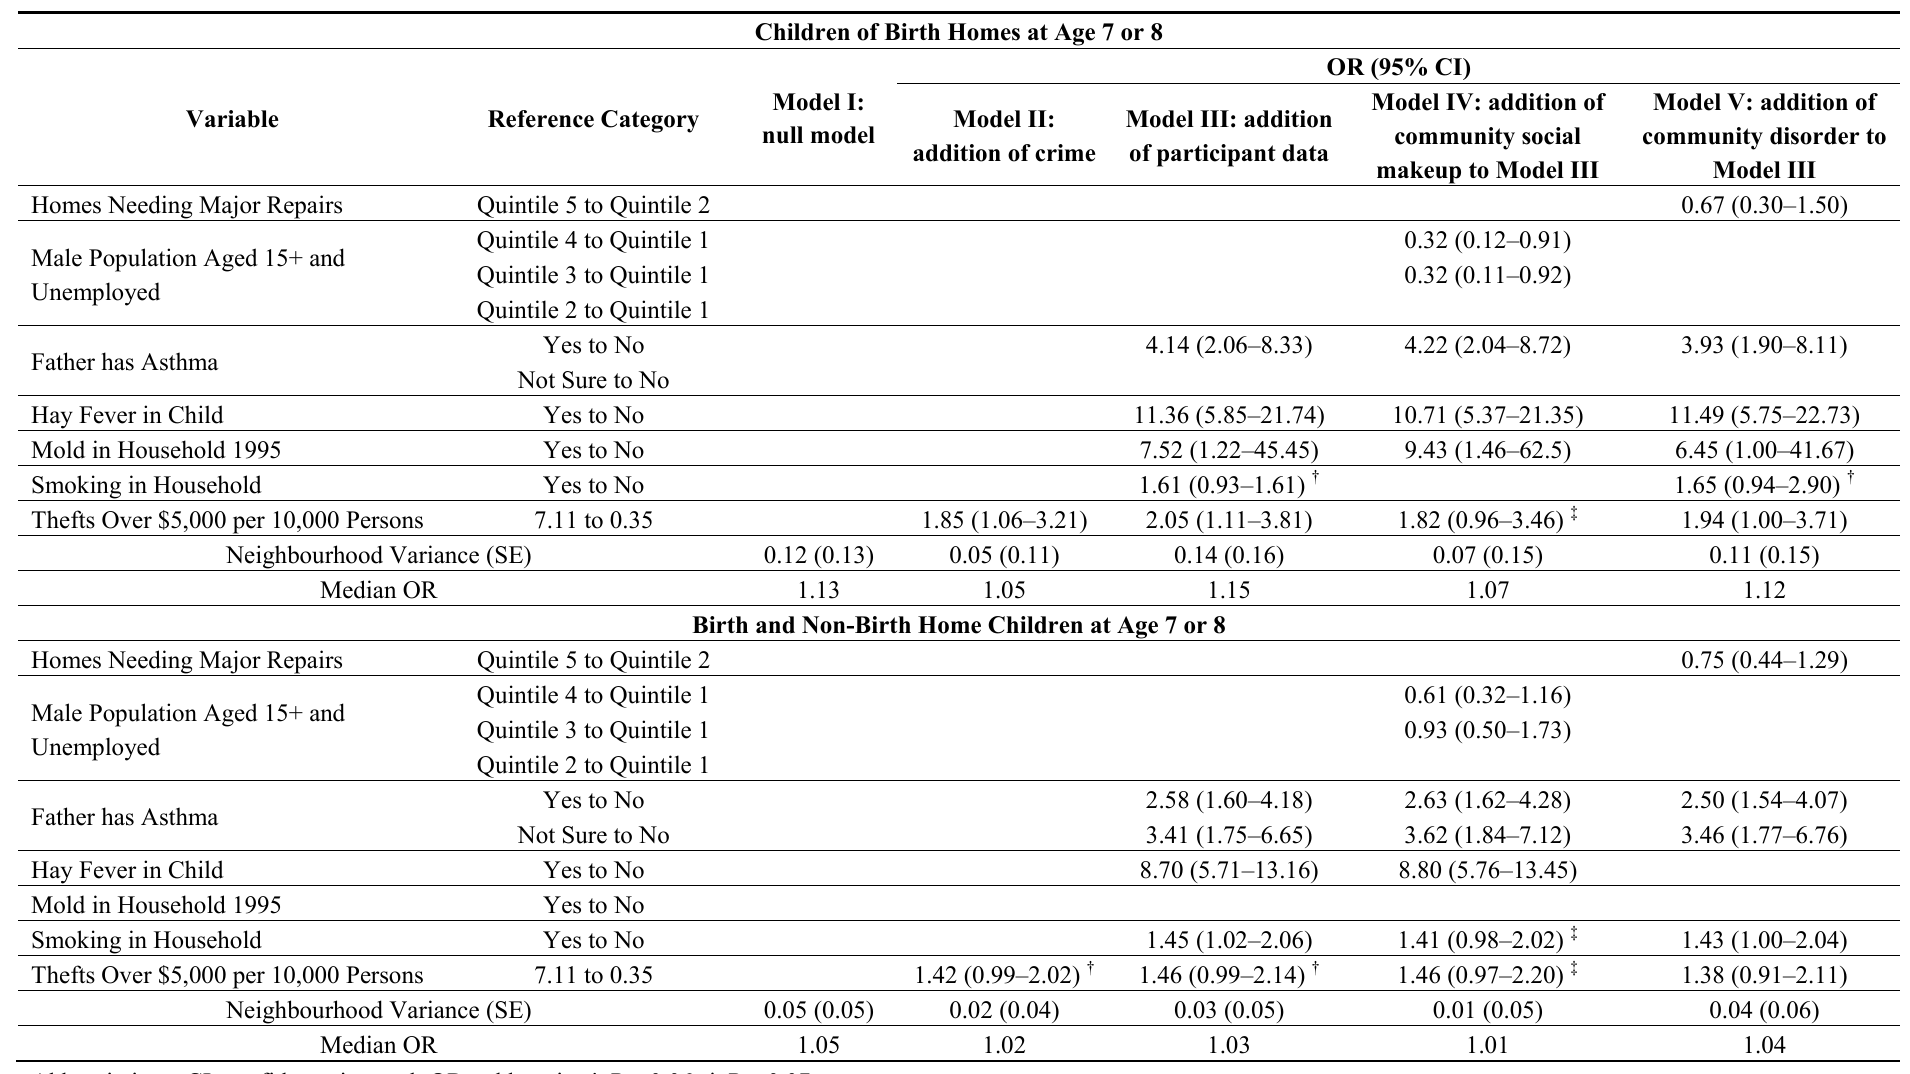
Table 3. Likelihood of Asthma in Winnipeg Schoolchildren According to Community Crime after Controlling for Other Community Stressor Domains and Potential